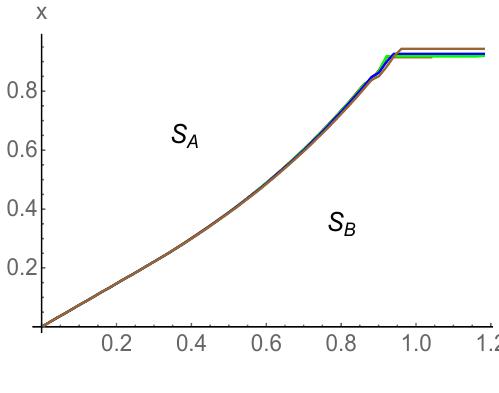
Figure 30 . Two strip phase diagram of the specious-con(cid:12)ned phase for various values of (cid:22) . The S A and S B phases correspond to the two connected bulk surfaces of (cid:12)gure 6. Here T=T c = 0 : 9 and red, green, blue and brown curves correspond to (cid:22) = 0, 0 : 1, 0 : 2 and 0 : 3 respectively. In units